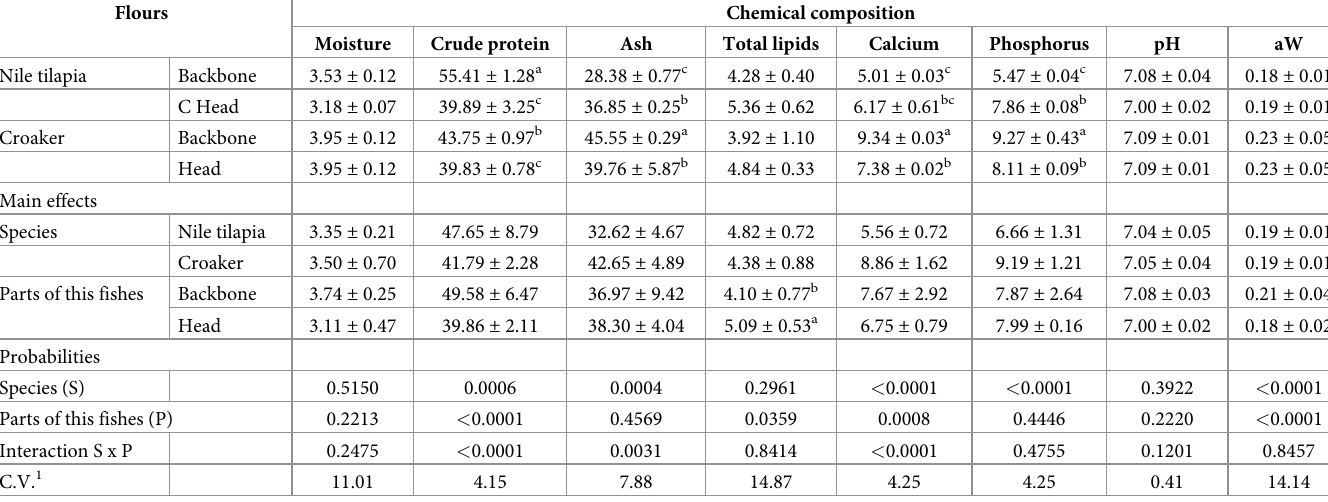
Averages in the same column followed by standard deviation with different lowercase letters are different from each other by Tukey’s test and Student’s t test. (P < 0.05); 1 C.V. = coefficient of